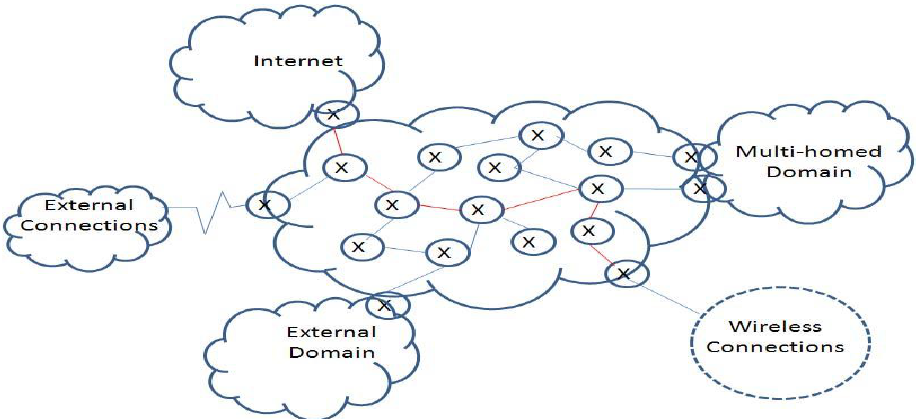
Figure 1. Typical Domain